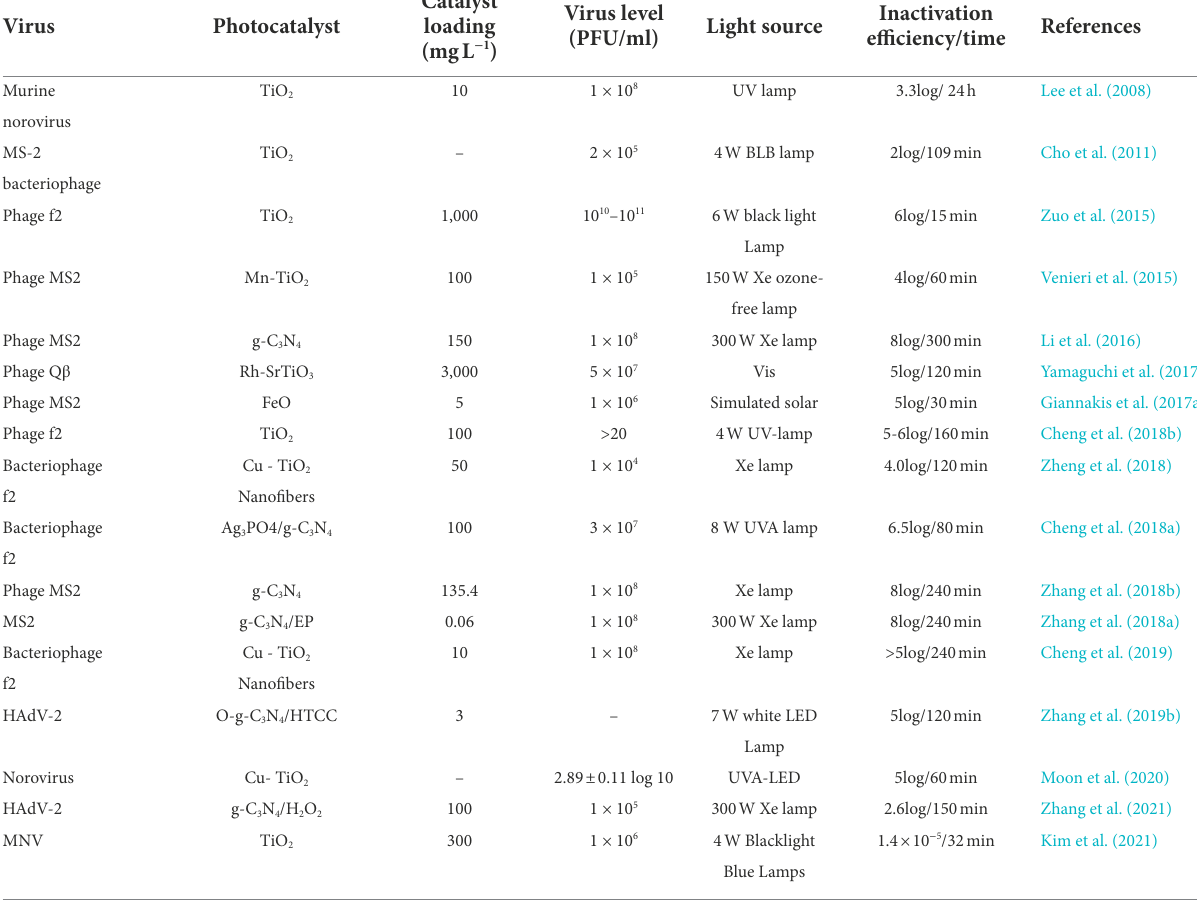
TABLE 3 Summary of parameters, inactivation efficiency, and photocatalysts used for viral disinfection in